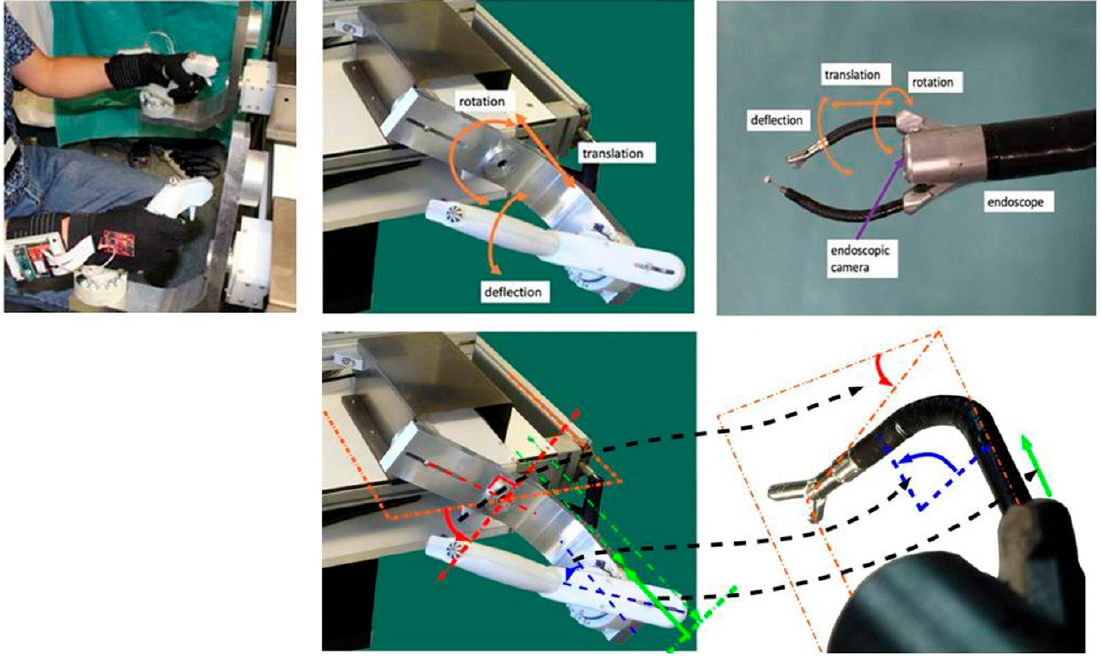
Figure 2. The sensor gloves in action ( top left ) on the handles of the robot master system. Joints of the master control system handles and directions of movement ( top middle ). Slave instruments at the distal extremities of the endoscope and directions of movement ( top right ). Master–slave movement mapping ( bottom right ).